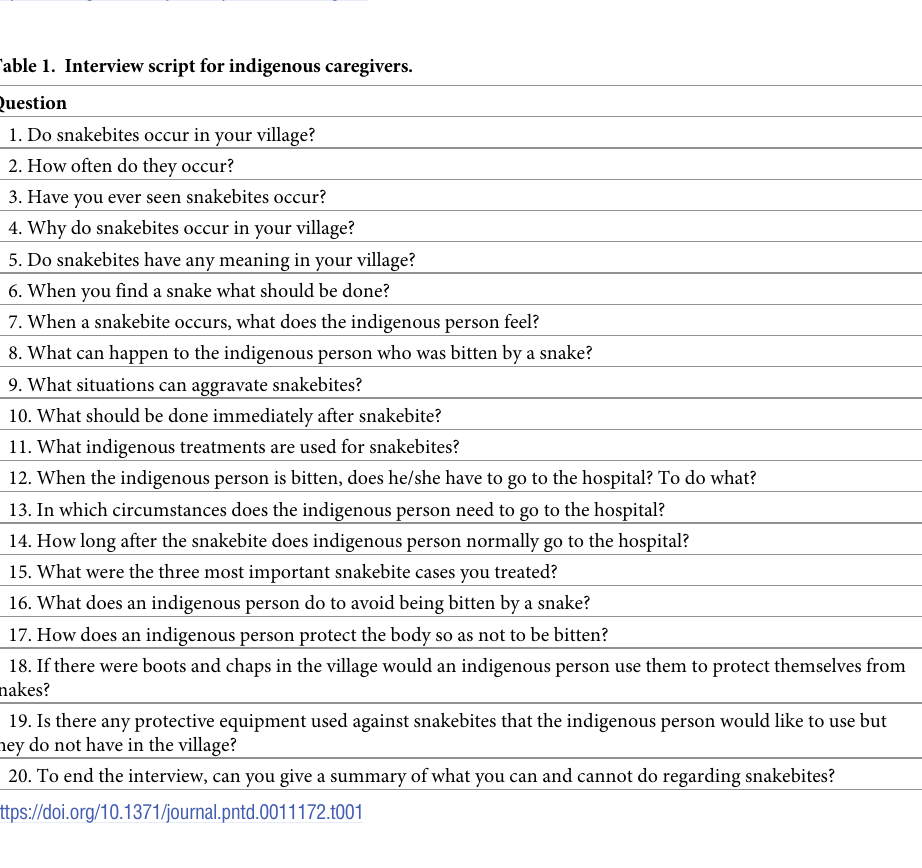
Fig 1. Location of the study area, in the Special Indigenous Health Districts named Alto Solim õ es River, in the state of Amazonas, western Brazilian Amazon. The location of the village of each caregiver is presented. The base used to create map is from the IBGE (Brazilian Institute of Geography and Statistics), which is freely accessible for creative use in shapefile format, in accordance with the Access to Information Law (12,527/2011) (https://geoftp.ibge. gov.br/cartas_e_mapas/bases_cartograficas_continuas/bc250/versao2019/).